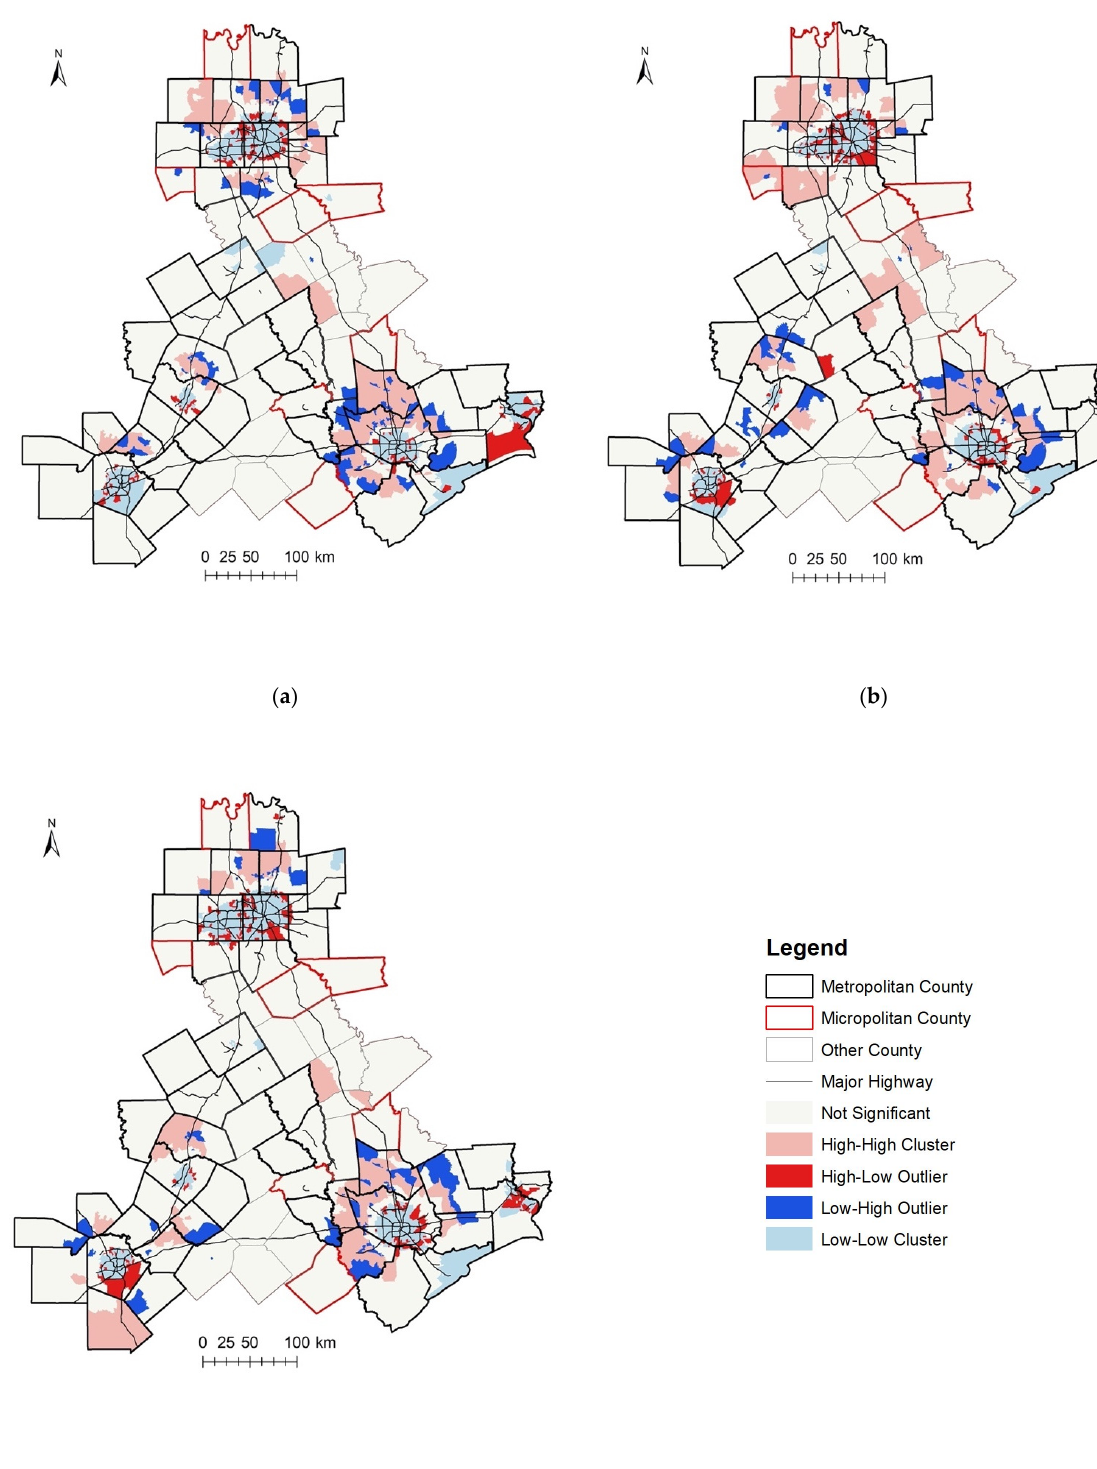
Figure 6. Spatial cluster and outliners of newly developed urbanized land ( a ) 2001–2006; ( b ) 2006–2011; ( c )